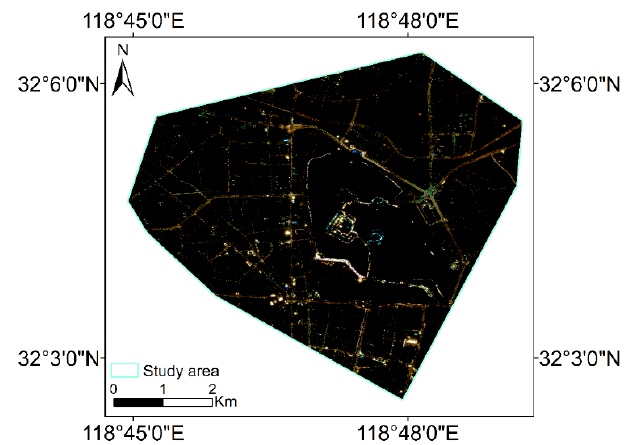
Figure 5. The JL1-3B image after preprocessing.